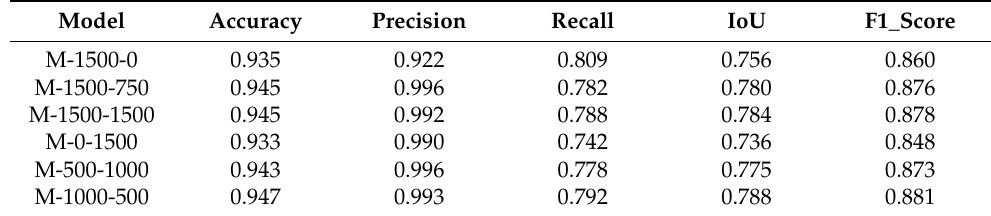
Table 3. Prediction results of Epoch 50 weights.